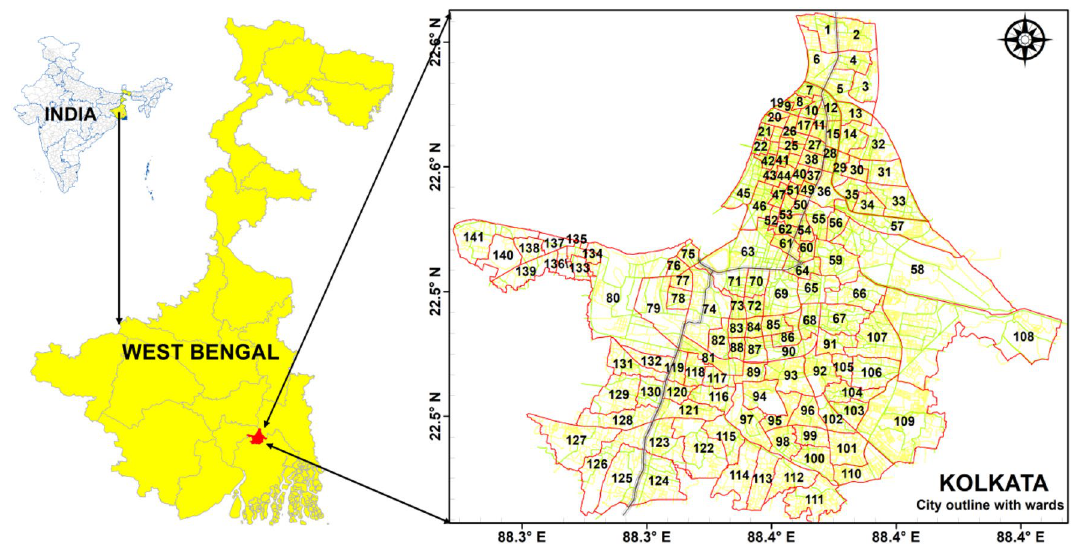
Fig. 1 Area of Interest (Kolkata with ward